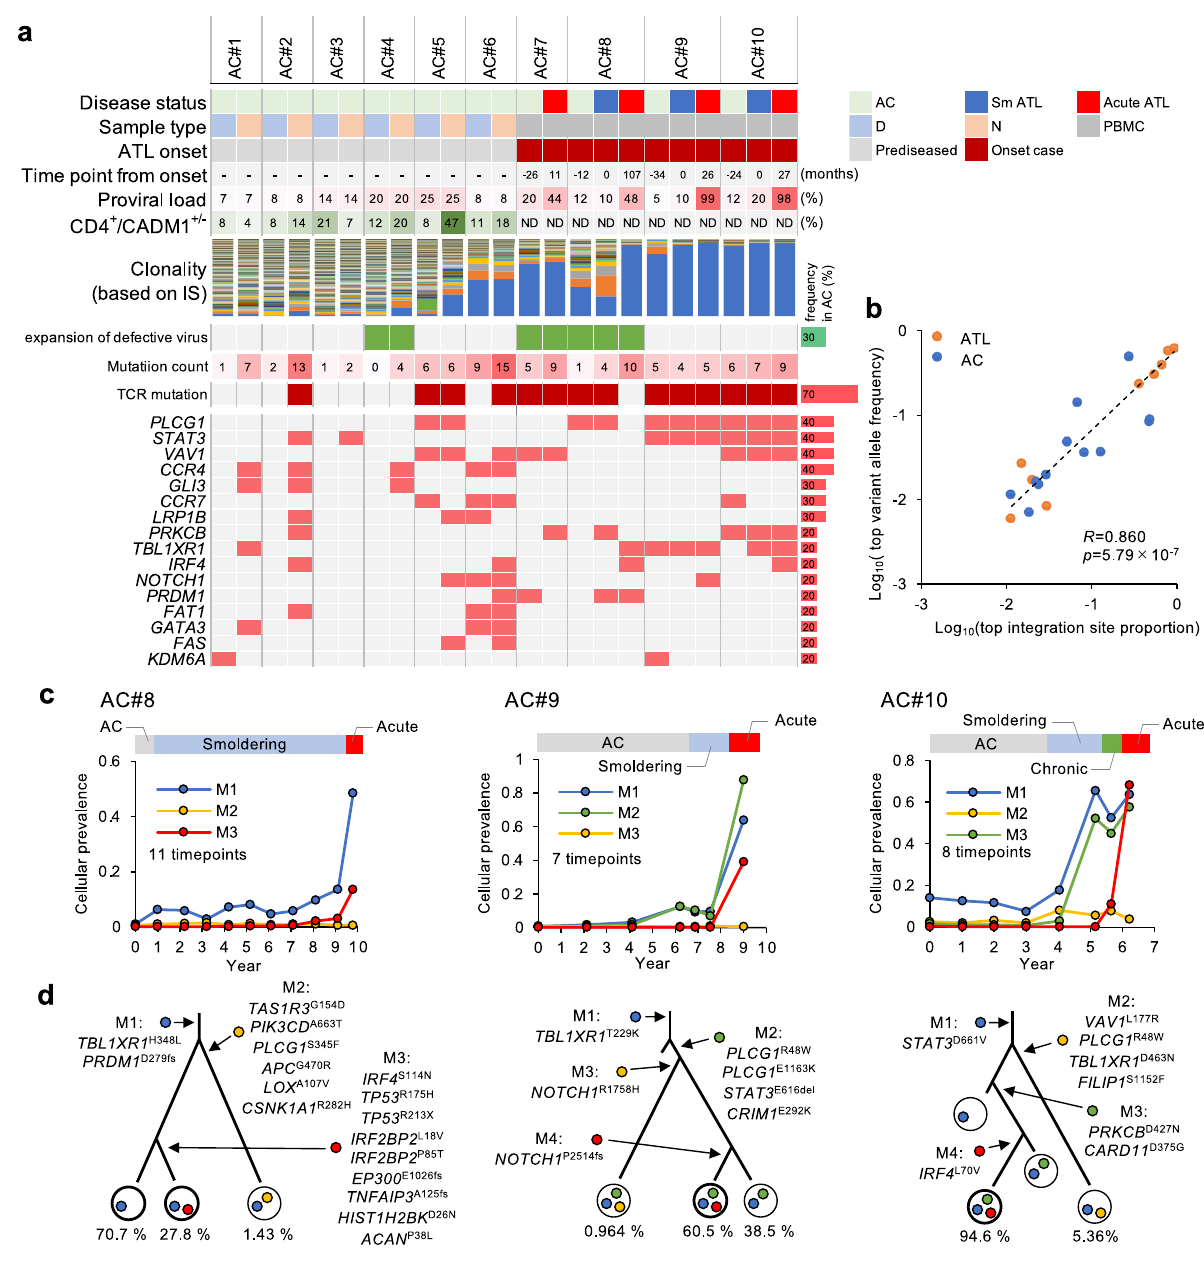
Fig. 6 Longitudinal genomic pro fi ling of asymptomatic HTLV-1 carriers. a Overview of the clonality and somatic mutations across 10 asymptomatic carriers (ACs). For #1 – 6, peripheral blood samples from asymptomatic donors were subjected in HAS- fl ow sorting to collect D and N subpopulations for quantifying very low-frequent mutations from polyclonal populations. For ATL progression cases (#7 – 10), PBMCs before and after diagnosis were subjected to deep sequencing. TCR pathway mutation was de fi ned by detection of PLCG1 , VAV1 , PRKCB , or CARD11 mutation ( ≥ 1) in major clones. Clonal mutations are de fi ned as mutations with VAF ≥ 0.01. Detailed detected mutations are provided in Supplementary Data 4. b Scatter plot shows major clone sizes estimated by VIS read counts ( x -axis) or VAF values ( y -axis) for each sample (Log 10 ). A two-sided Spearman test was performed ( n = 21 samples). c , d Clonal evolution in disease progression cases (AC#8 – 10; follow-up period, 6 – 9 years). Collected samples included PBMCs at AC (before onset), indolent ATL, and after acute transformation. Line plots show chronological transition of cellular prevalence of imputed mutational subclusters ( c ). Subclonal information and imputed mutational subclusters in each sample are depicted in phylogenetic trees ( d achieved through the integration of biological and reliable genetic sensitivity (e.g., targeted ampli fi cation 17,18 ) and read length (e.g., data to provide the shortest path for personalized care. long-read technology 50 ), as well as utilization of future applica- tions enabling simultaneous DNA-seq and RNA-seq in depth at a single-cell resolution, should lead to the development of approaches for the early diagnosis and pre-emptive therapeutic strategy for this disease, which currently has a poor prognosis. Early detection and characterization of a minimal premalignant clone, which can develop into a fully malignant clone, may be disorders and systemic infections, were excluded. Lymphoma-type patients were